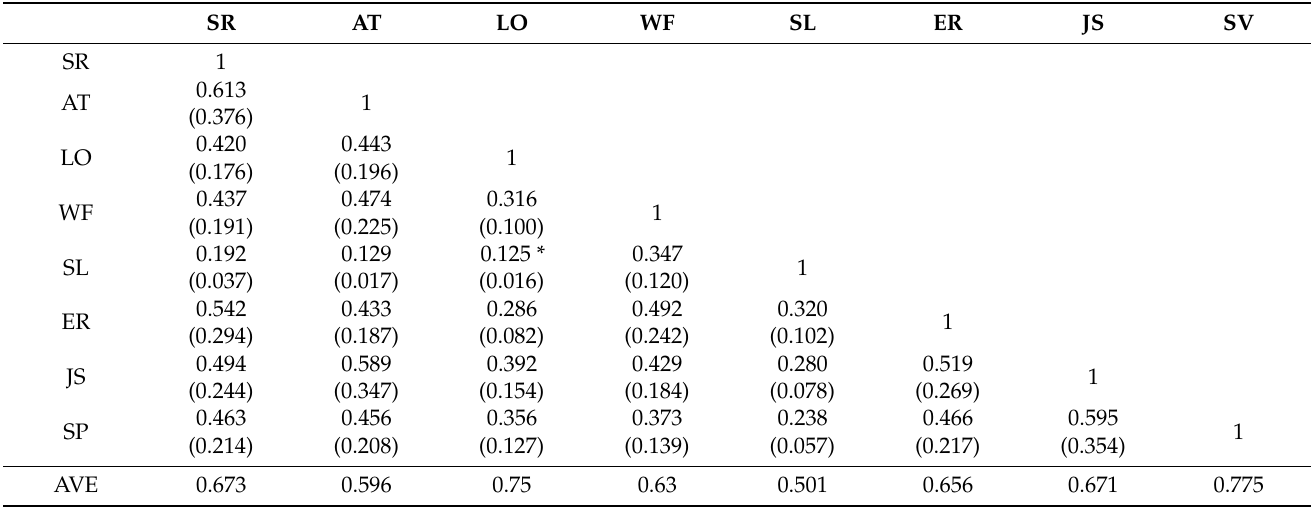
Table 4. Results of correlation analysis between variables.